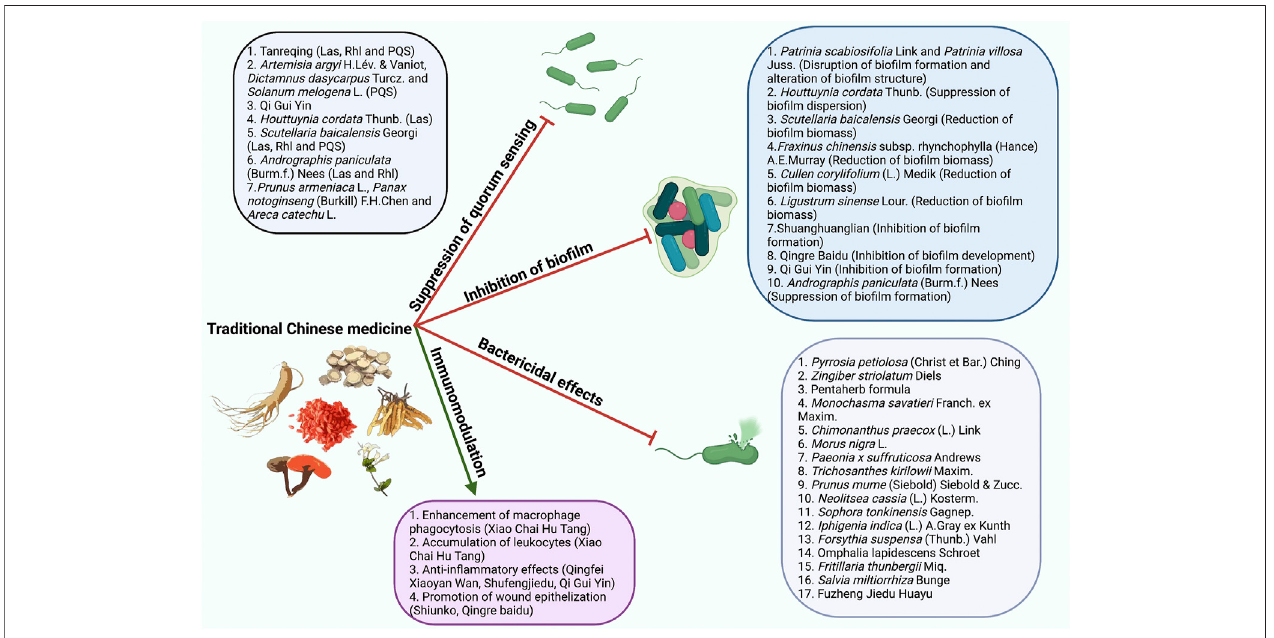
FIGURE 1 | The mechanisms of TCM combating P. aeruginosa infections. TCM controls P. aeruginosa infections through suppression of QS, inhibition of bio fi lm, bactericidal effects, and modulation of host immune responses.